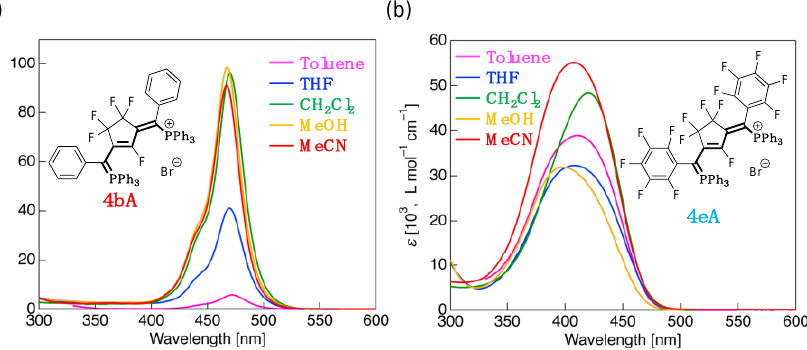
Figure 8. UV-vis absorption spectra measured in various solvents for: ( a ) 4bA (R = phenyl, C 6 H 5 ); ( b ) 4eA (R = pentaphenyl, C 6 F 6 ).